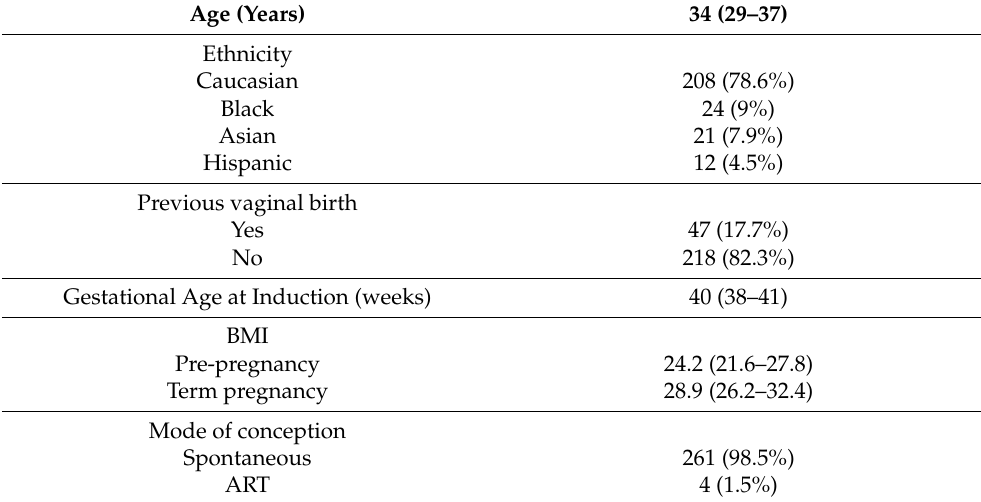
Table 1. General clinical characteristics of the women included in the study.